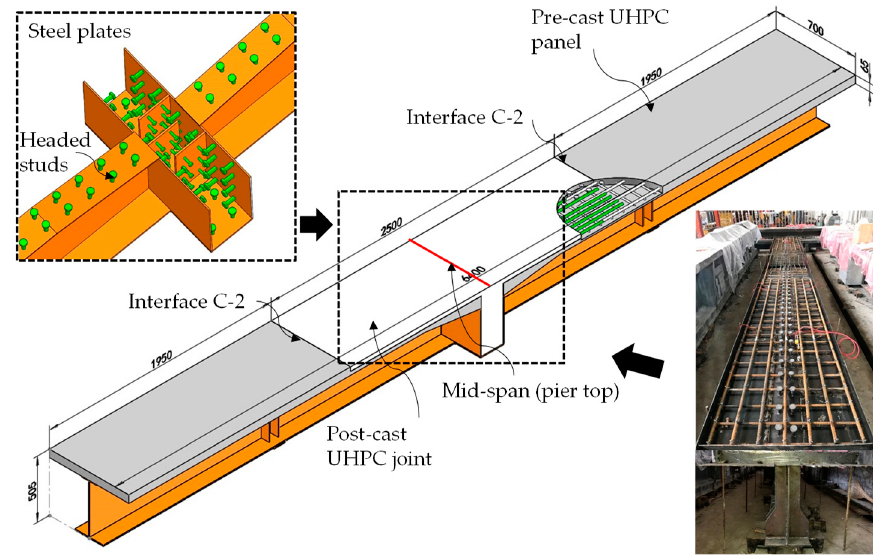
Figure 9. Diagram of the second generation T-shaped joint model test specimen.